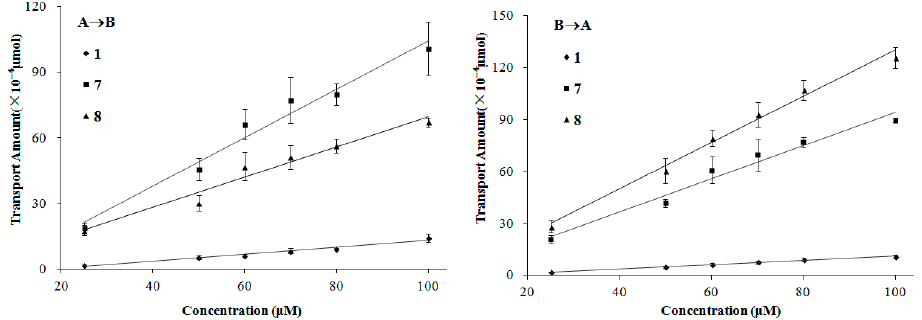
Figure 6. The transport amount at the different concentration (25–100 µM). The experiment was carried out in triplicate. Data are mean ± SD. A → B: Transport from the apical to the basolateral side; B → A: Transport from the basolateral to the apical side.